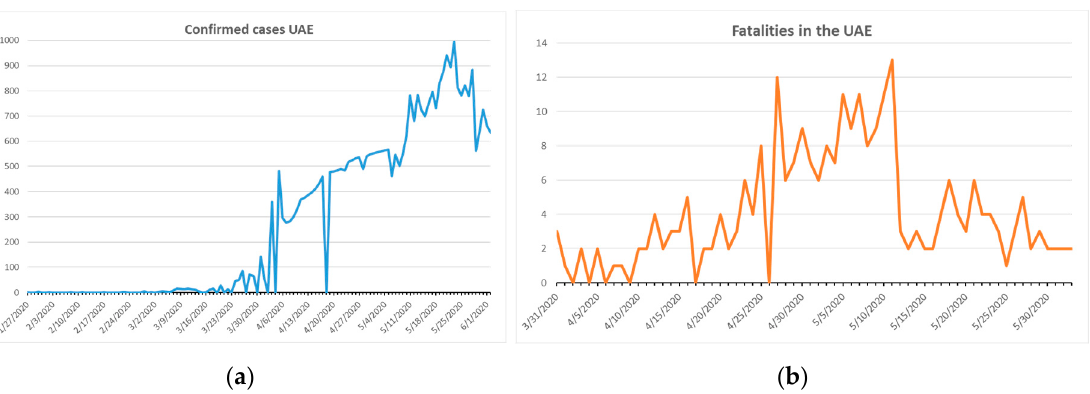
Figure 8. Confirmed COVID-19 cases and fatalities in the UAE until 2 June 2020 [18]. First confirmed case on 27 January 2020, first fatality on 22 March 2020 in UAE. From left to right: ( a ) confirmed cases in the UAE; ( b ) fatalities in the UAE.